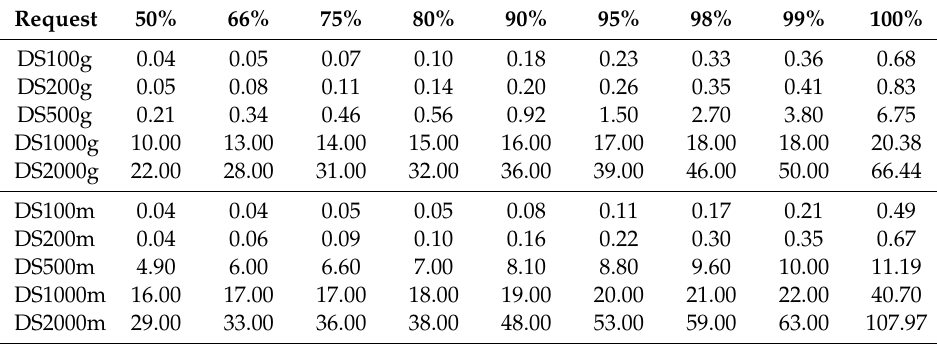
Table 17. Percentage of describeSensor requests completed within given times (in seconds) for the different configuration of concurrent users and WSGI server (case C).